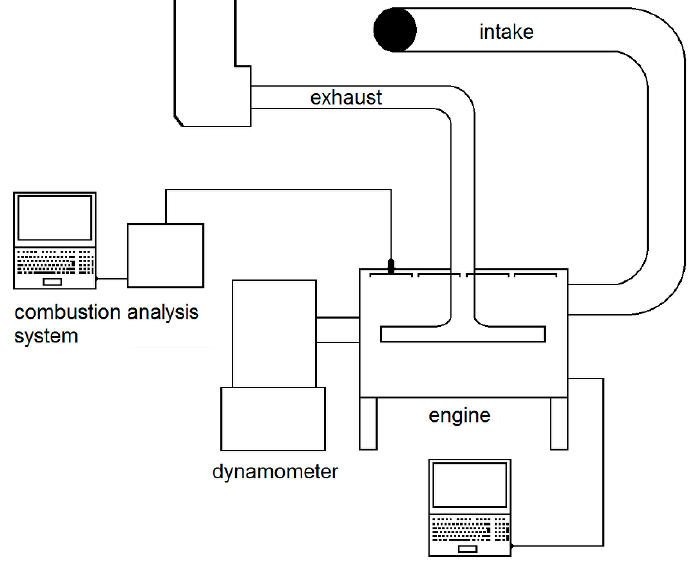
Figure 1. Schematics of the experimental system.